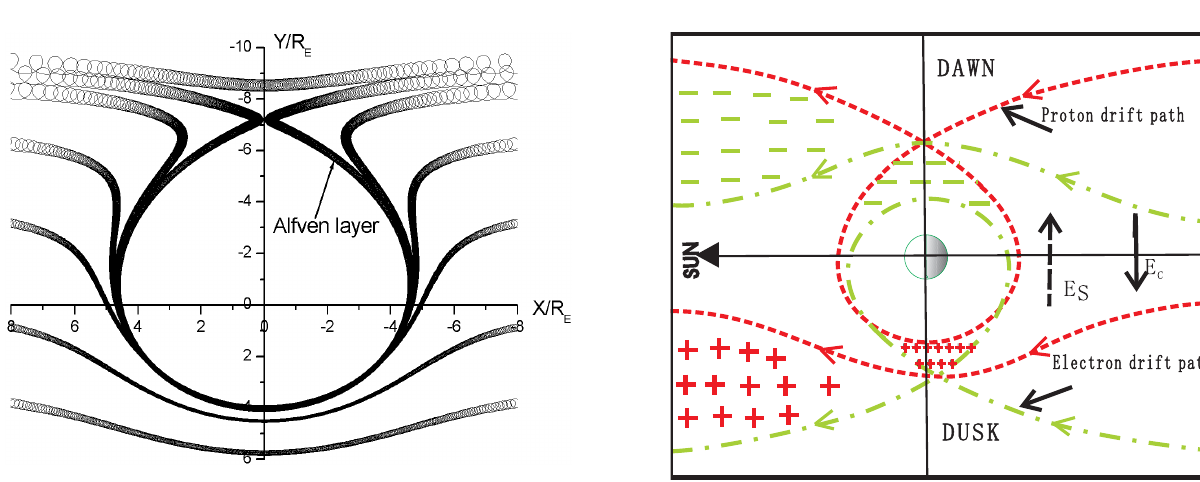
Fig. 2. Sketch of drift paths of ions and electrons moving in a dipole magnetic field with a uniform electric